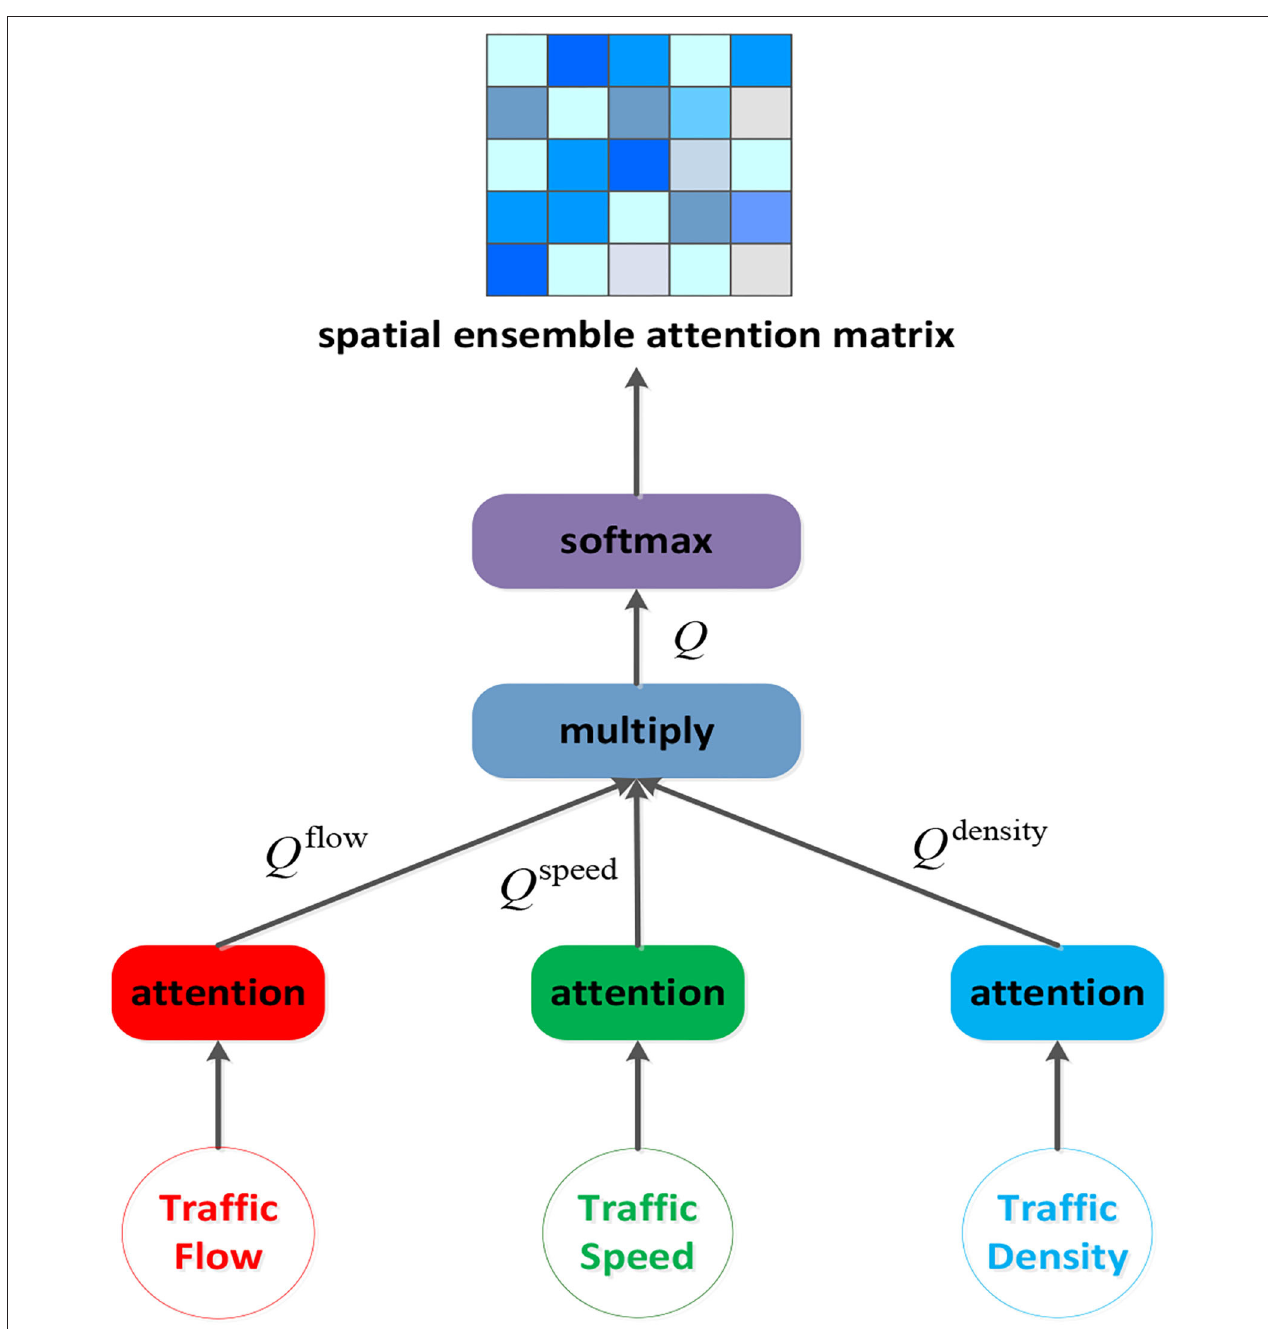
FIGURE 4 | The structure of spatial ensemble attention layer.